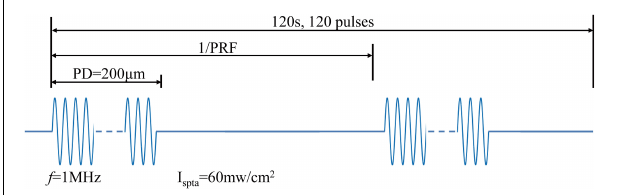
FIGURE 4 | Ultrasound stimulated signal for TMAS in live animal